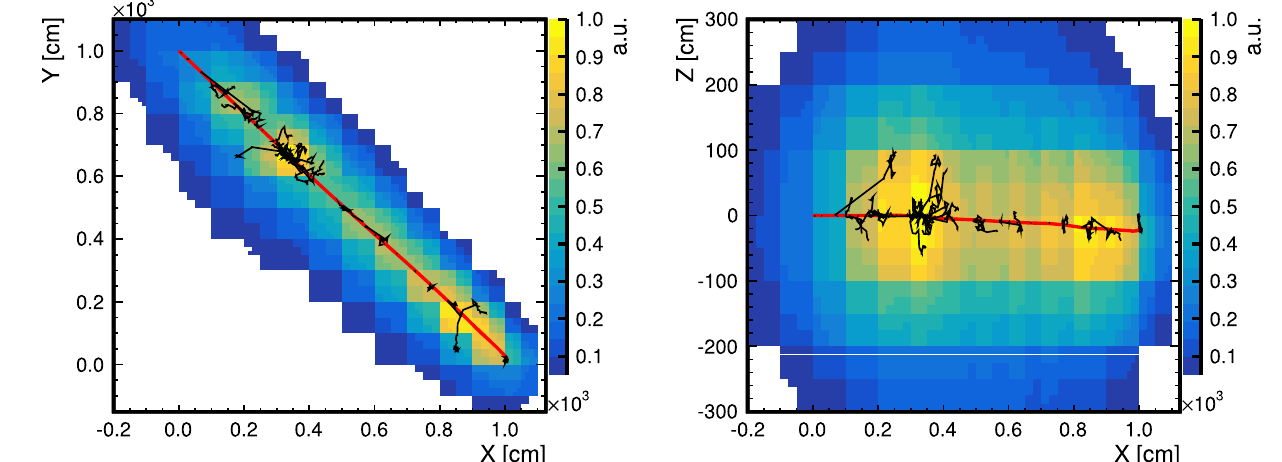
jected tracks of the primary particle (red) and of secondary particles (black) are shown. The cell content is given in a.u. and rescaled such that the maximum content is 1. The plots are taken from [32], which provides details on the reconstruction procedure